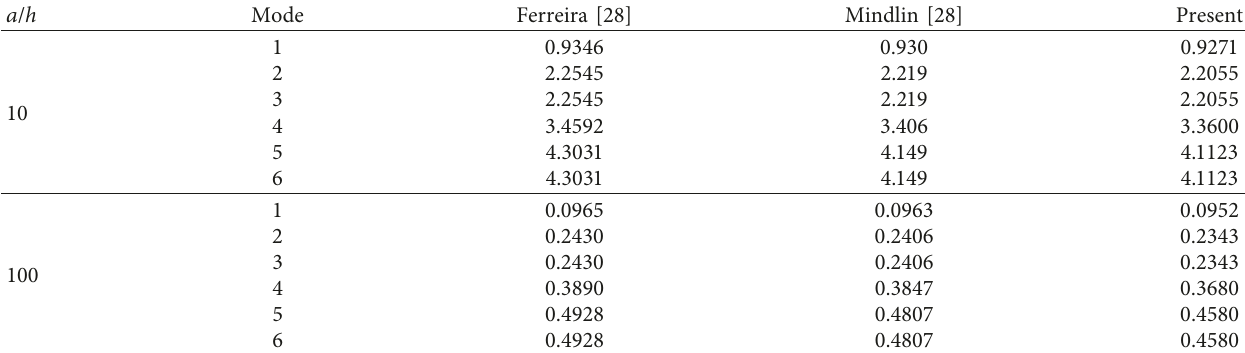
Table 6: Comparison of the nondimensional frequencies of an SSSS plate.